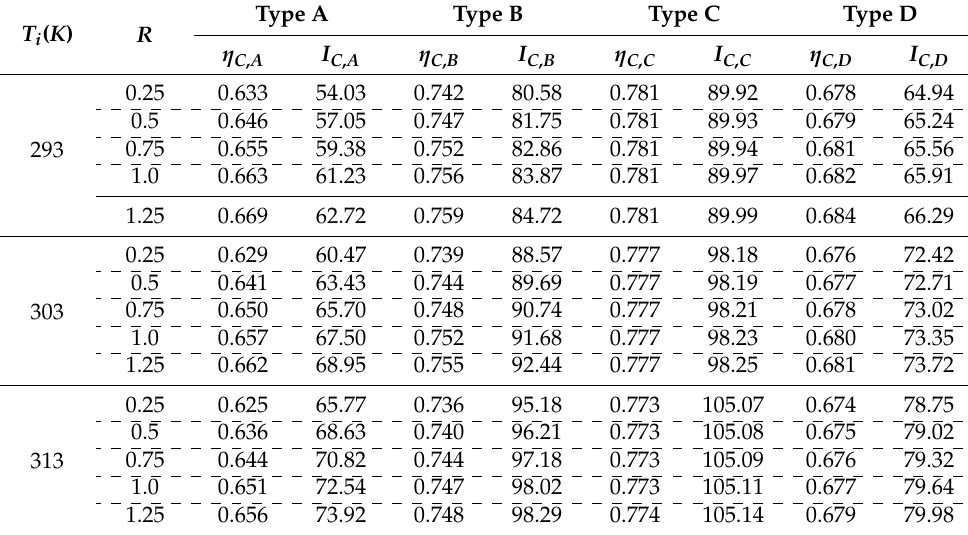
Table 8. Theoretical predictions of collector efficiency and collector efficiency improvement for I 0 = 1100 W/m 2 and ˙m = 0.0214